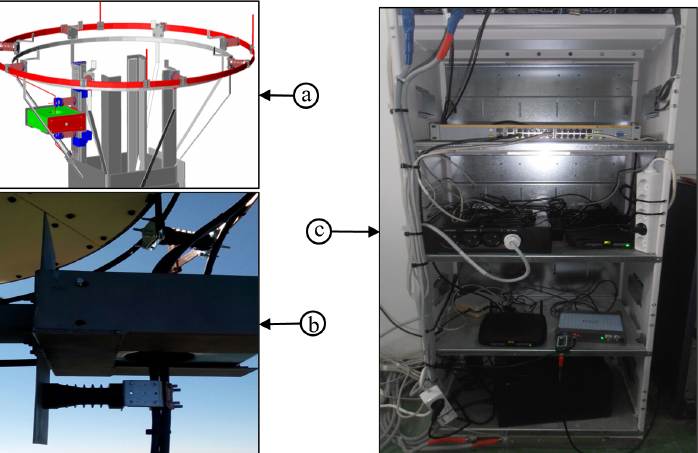
Figure 3. Measuring equipment on the site: ( a ) 3D view of the mounting of the current transformer, ( b ) current transformer, and ( c ) recording unit and power supply unit.